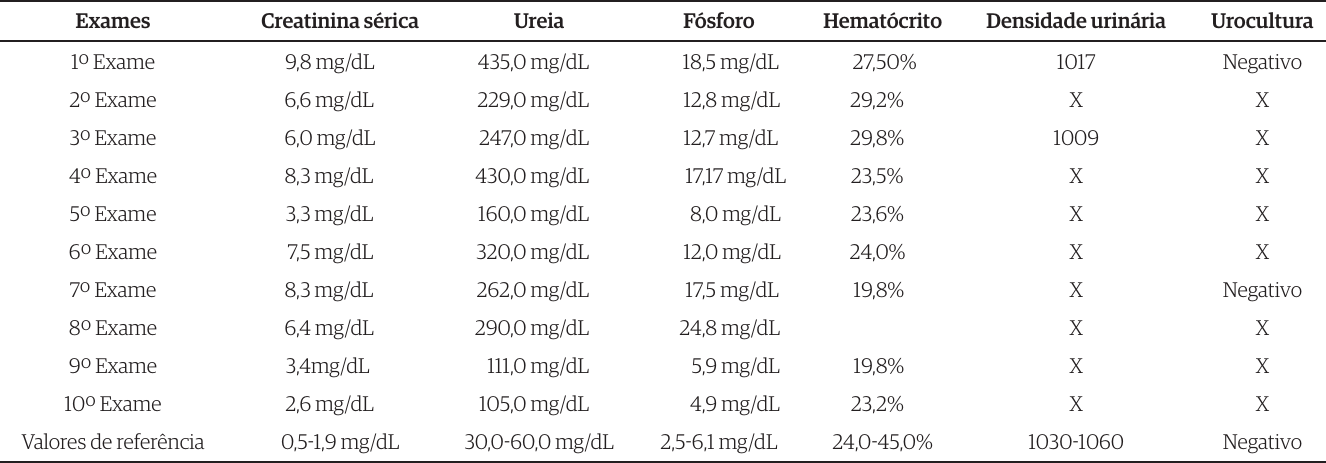
Tabela 2. Resultado dos exames laboratoriais realizados durante 3 meses de